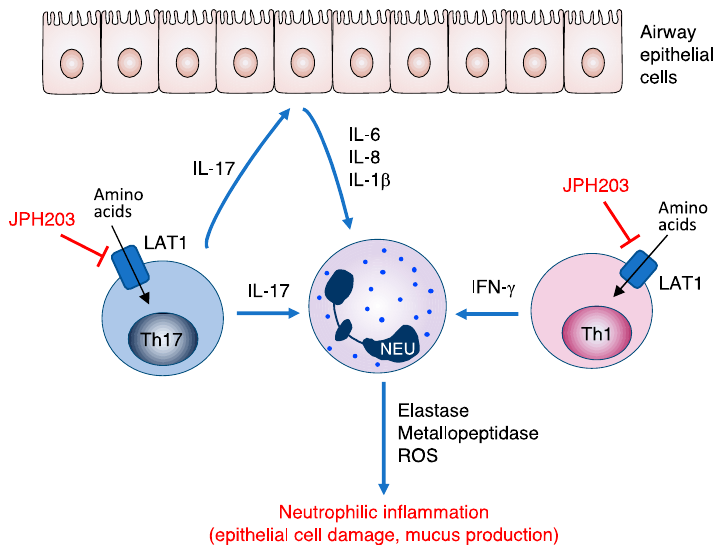
Figure 3. Possible management of steroid-resistant asthma by JPH203. T helper (Th) 17 and Th1 cells activate neutrophils, which causes progression of steroid-resistant asthma. JPH203 potentially terminates the disease cascade by starving amino acids in those cells. LAT1: L-type amino acid transporter 1, ROS: reactive oxygen species, NEU: neutrophil.